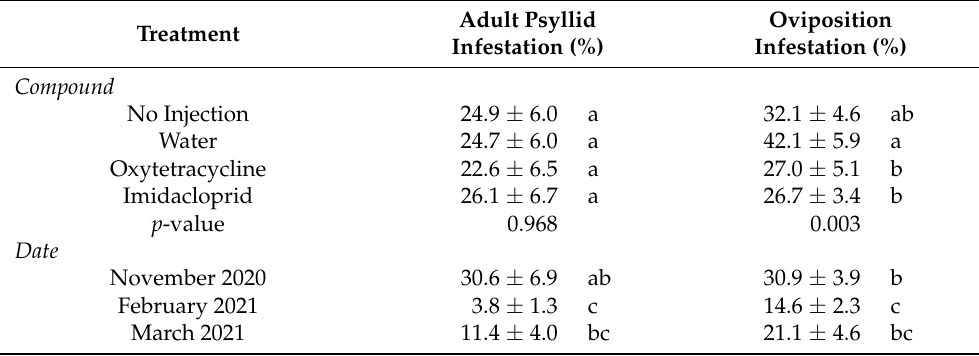
Table 1. Natural adult psyllid and oviposition infestation (%) during main flushing times after injection in October 2020 and April